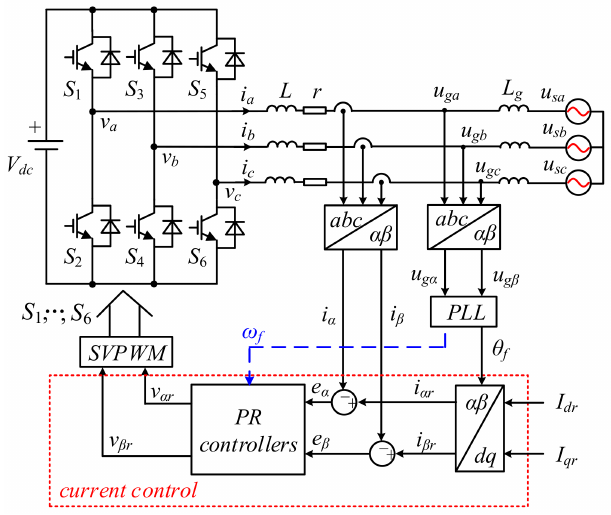
Figure 2. Block diagram of a voltage source converter (VSC) with adaptive PR controllers for grid-connected